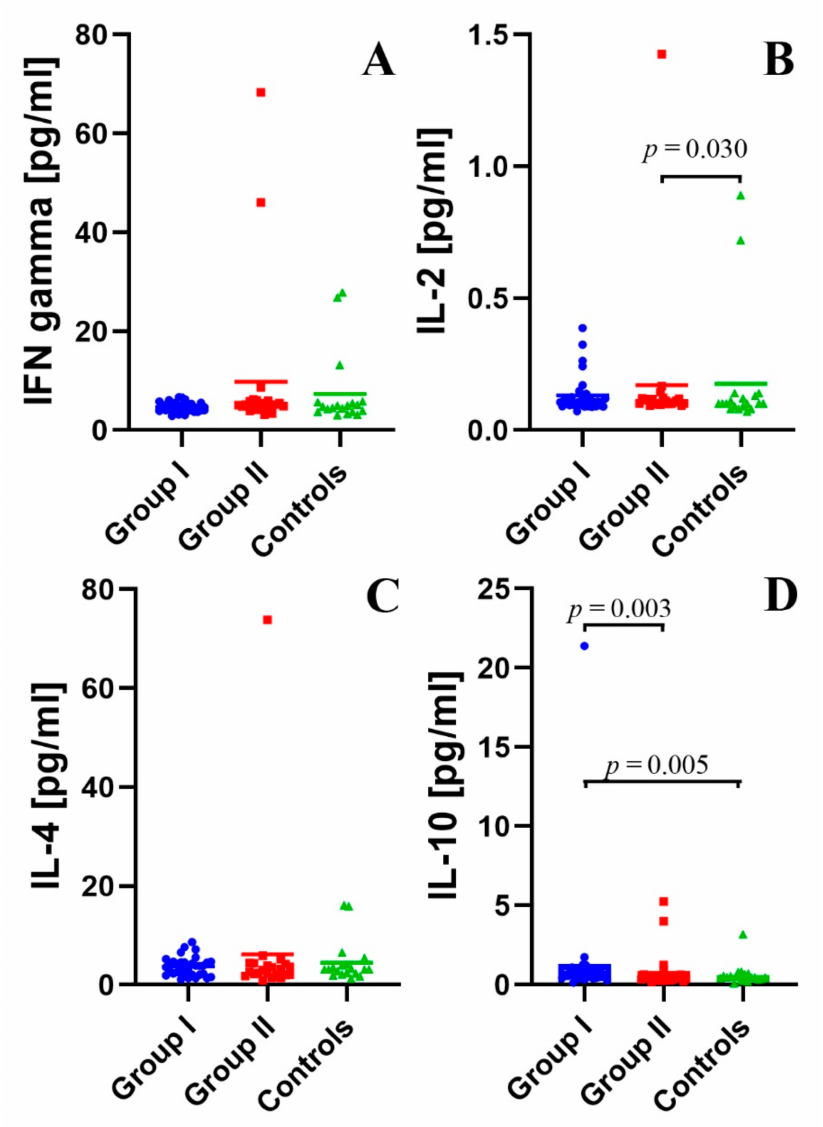
Figure 2. ( A – D ). Selected plasma cytokine